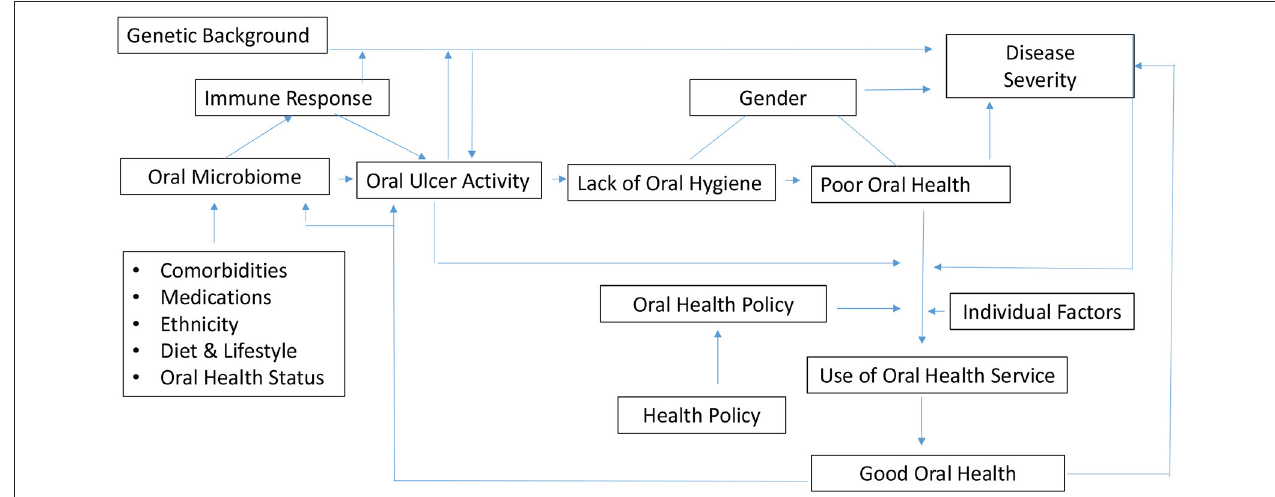
FIGURE 1 | Overview of oral health as part of the aetiopathogenesis in Behçet’s